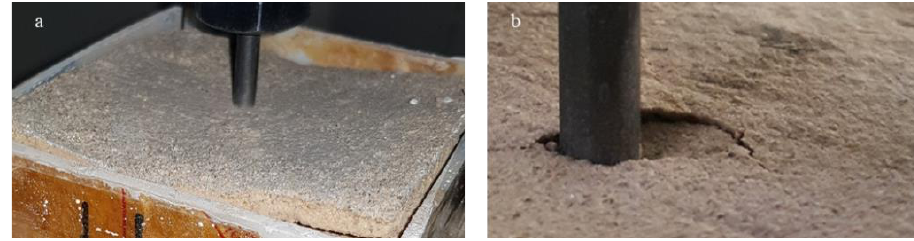
Figure 10. Two different failure modes in terms of ( a ) Complete failure, ( b ) Punching failure.